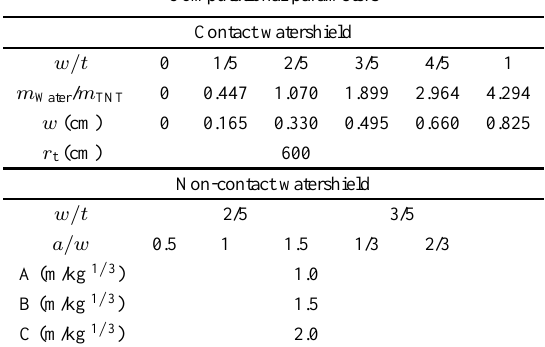
Computational parameters Contact